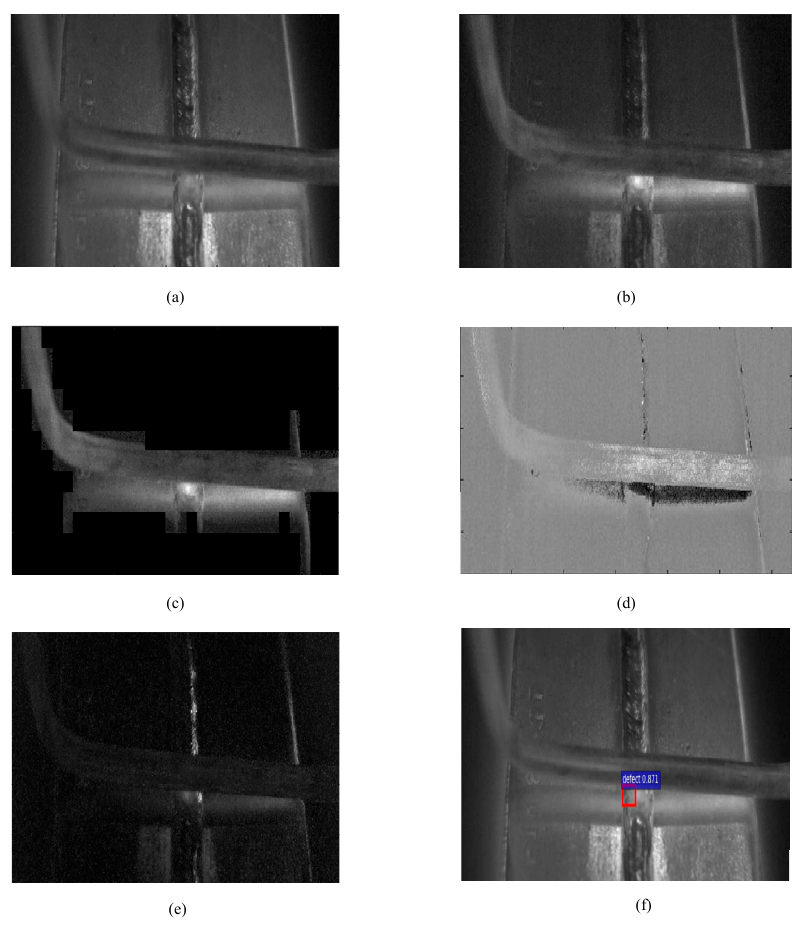
Figure 8. Flaws detection results provided by different algorithms on welding line sample (e): ( a ) TSR; ( b ) PPT; ( c ) ARDVB; ( d ) EVBTF; ( e ) SVD ‐ RARX; ( f ) proposed method.